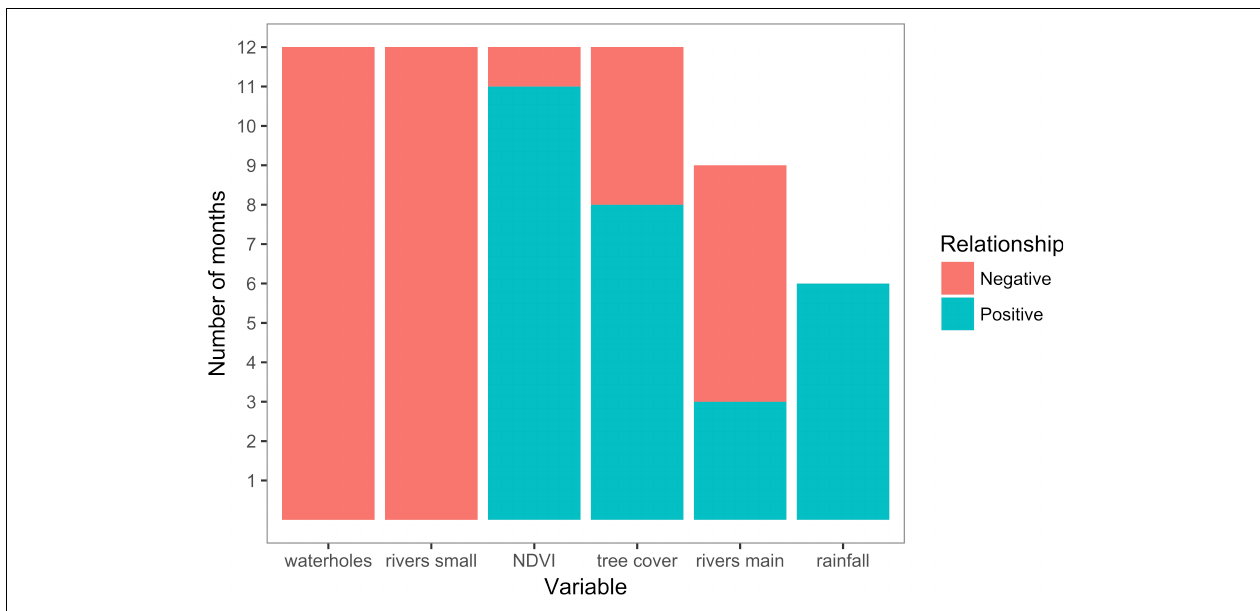
FIGURE 2 | Variables presence and coefficient sign across monthly path-selection models. NDVI was negative only in April 2016, tree cover in December 2015 and May-June 2016, main rivers in October-December 2015 and June-August